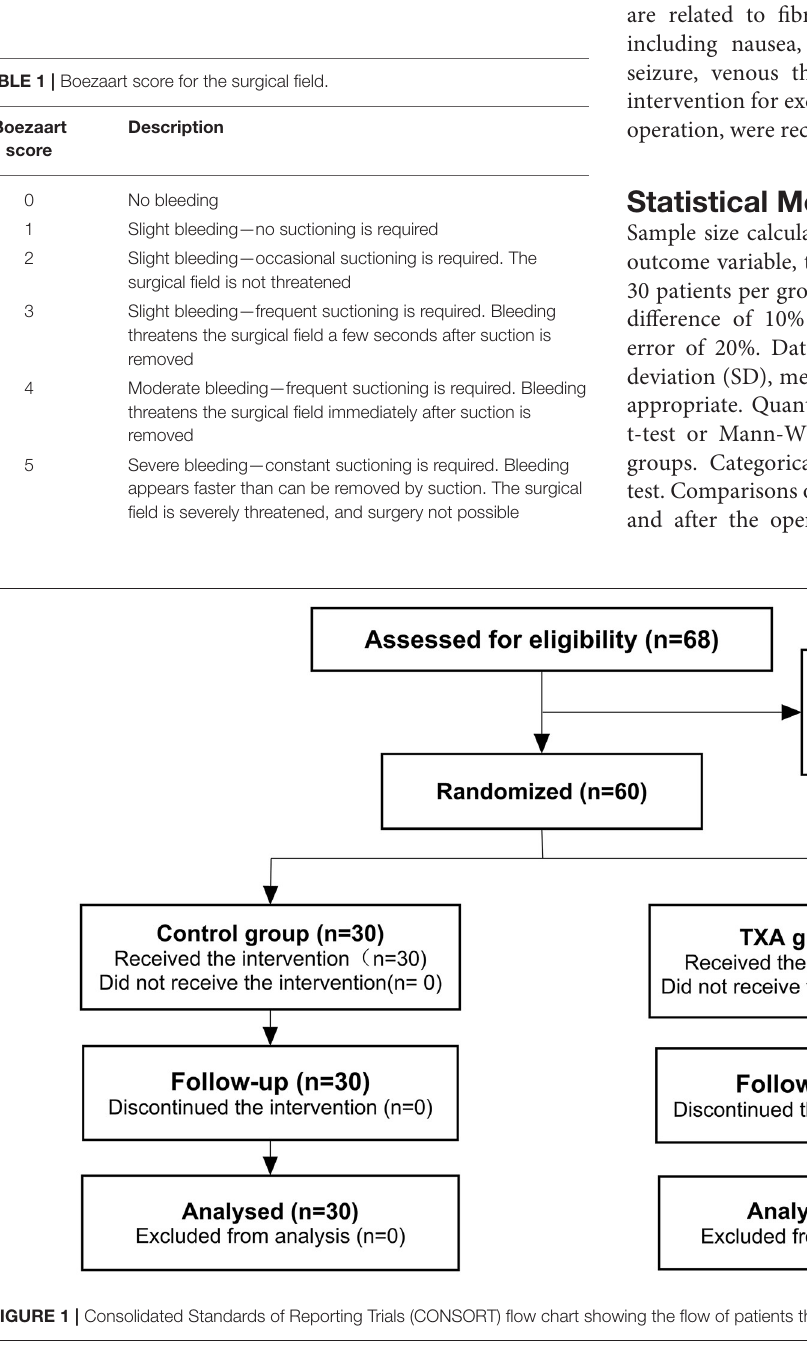
Frontiers in Surgery |